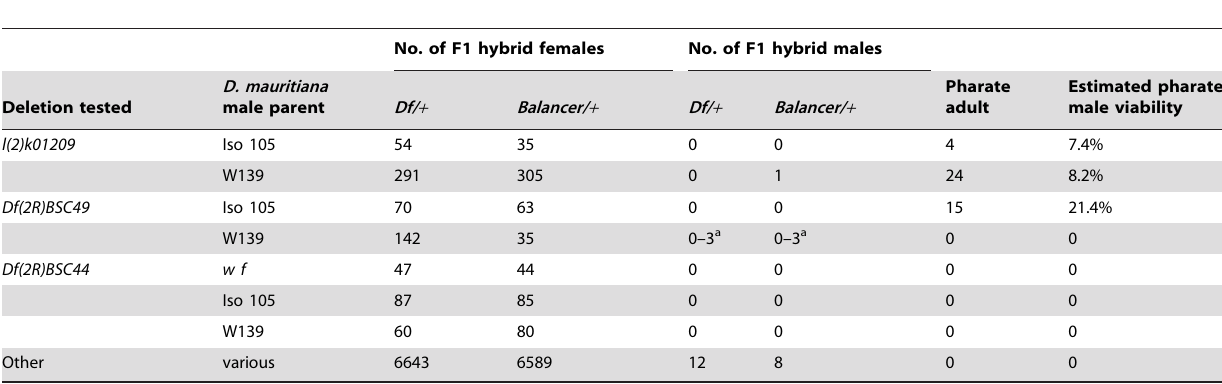
Table 3. Rescue of D. melanogaster/D. mauritiana hybrid male lethality by D. melanogaster Lhr 2